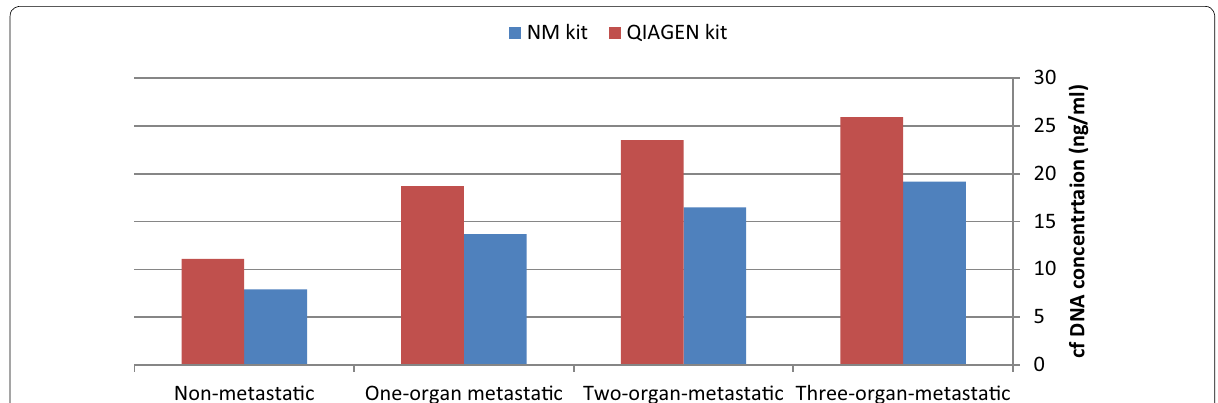
Fig. 1 Circulating free DNA concentrations (ng/ml) in association with metastasis